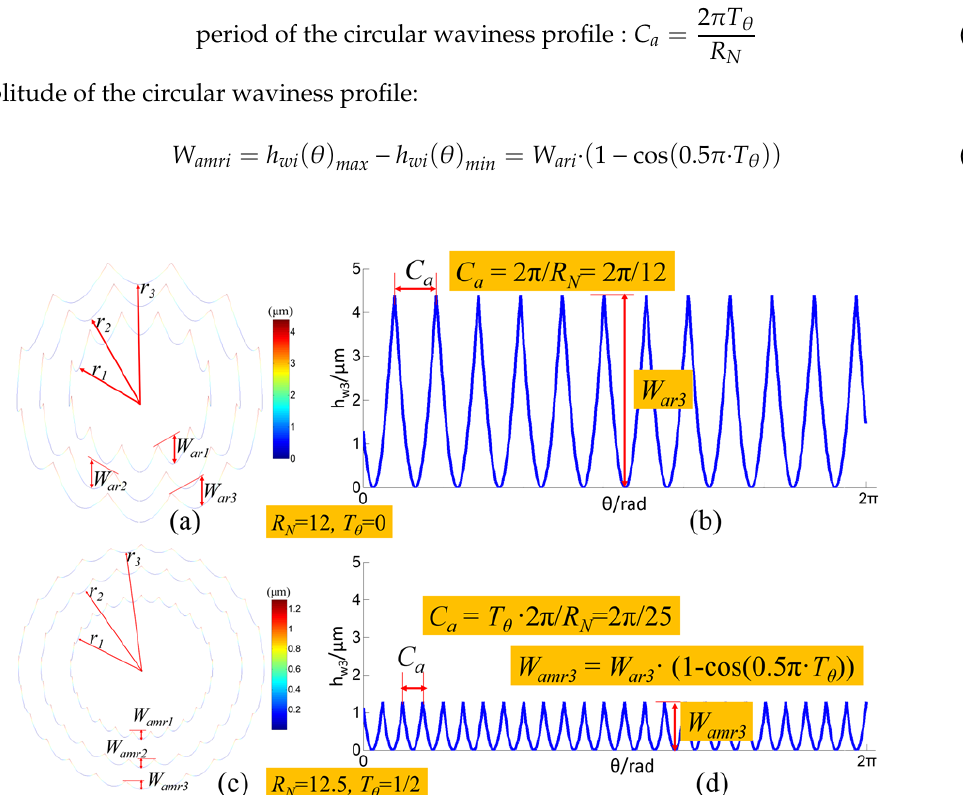
Figure 8. Simulation of the circular waviness profiles on the edge of each circle surface of the Fresnel micro-structured mold based on the waviness interference-overlapping effect. ( a ) circular waviness profiles of integer RSR; ( b ) horizontal expansion of the outermost circular waviness profile of integer RSR; ( c ) circular waviness profiles of non-integer RSR; ( d ) horizontal expansion of the outermost circular waviness profile of non-integer RSR.